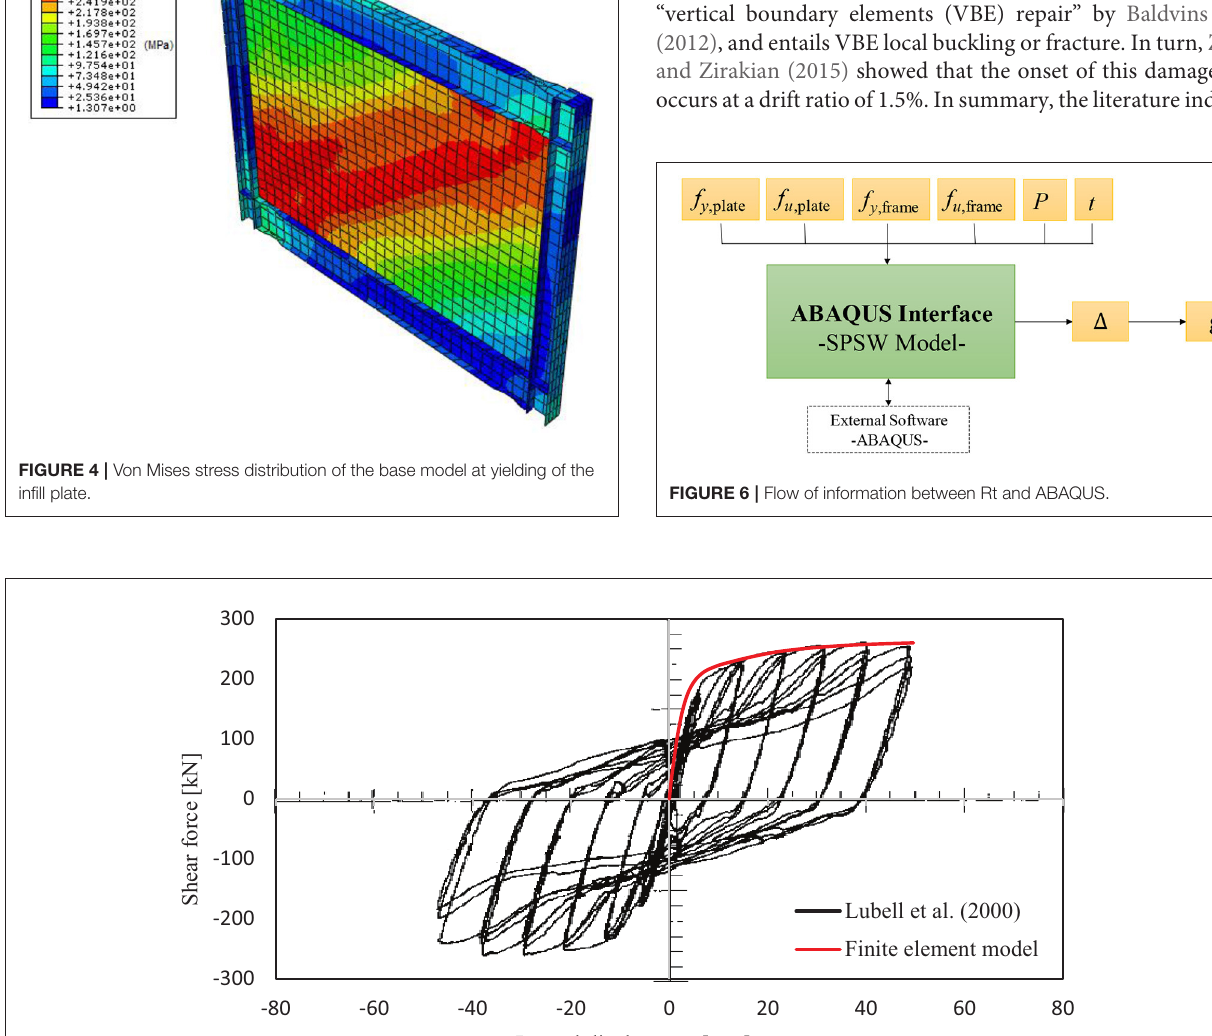
Frontiers in Built Environment |